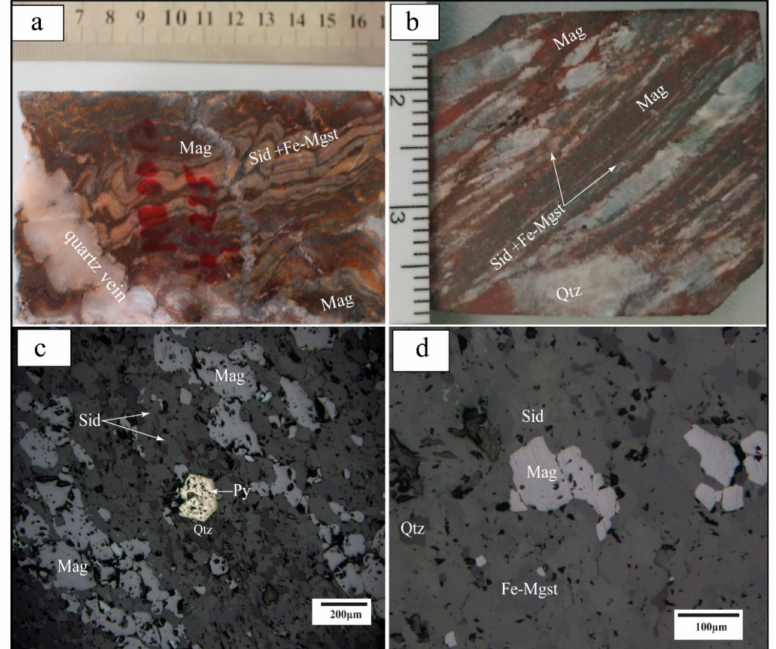
Figure 6. Core sample photos ( a , b ) and photomicrographs of the carbonate-oxide facies-BIF ( c , d ): ( a ) folded micro-banding of alternating quartz and ferric minerals (magnetite, siderite, and ferroan- magnesite) cut by a quartz vein (sample CG-NB10); ( b ) alternating thick quartz-rich and ferric mineral-rich (magnetite, siderite, and ferroan-magnesite) layers (sample CG-NB10); ( c ) euhedral pyrite inclusions in iron oxide-rich layer (sample CG-NB1). Note the lineation of magnetite, siderite, and quartz; ( d ) subhedral magnetite in the carbonate layers, mostly dominated by siderite (sample CG-NB1). Abbreviations: Fe-Mgst: ferroan-magnesite; Mag: magnetite; Py: pyrite; Qtz: quartz; Sid: